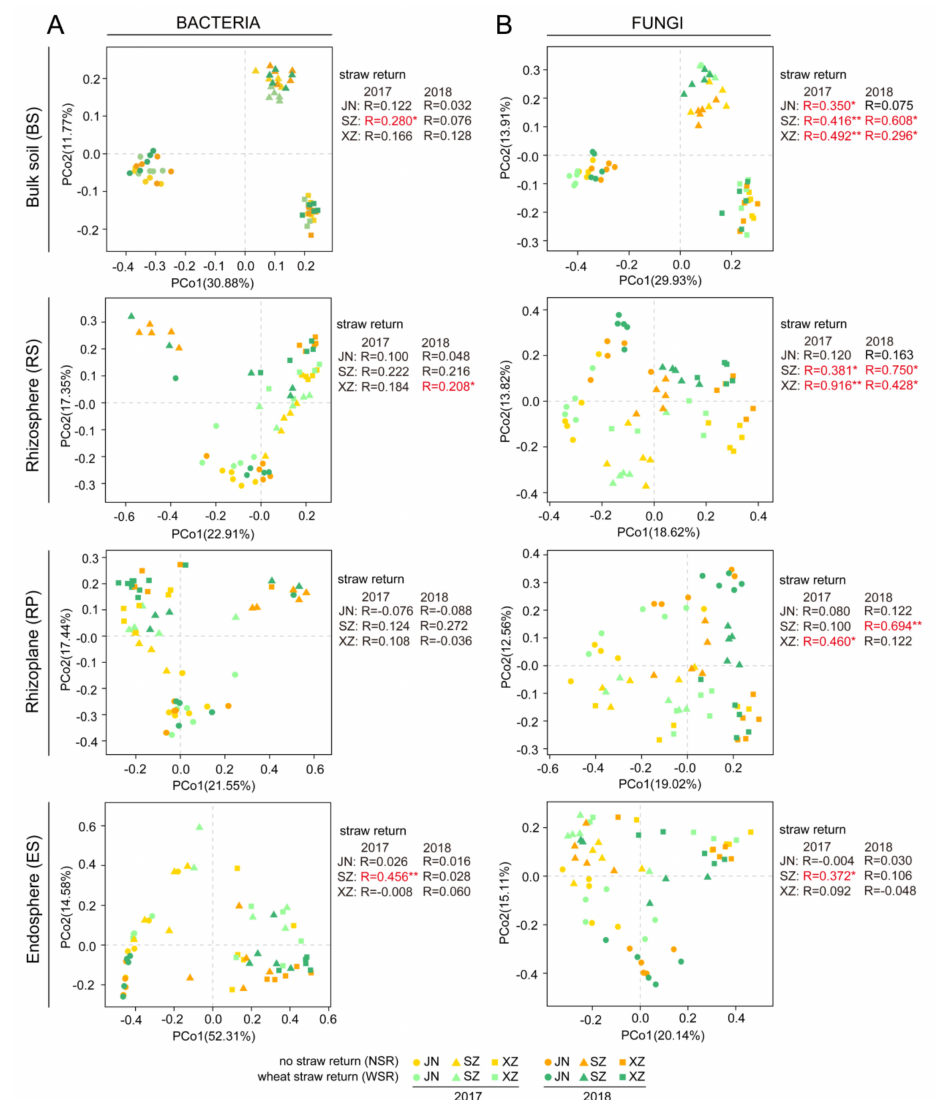
Figure 3. PCoAs showing the influence of WSR on bacterial ( A ) and fungal ( B ) community composi- tion in bulk soil (BS), rhizosphere (RS), rhizoplane (RP), and endosphere (ES) based on Bray–Curtis dissimilarities. ANOSIM was applied to test for differences in community composition due to WSR across different compartments, sites, and years; R values are indicated with “*” for p < 0.05, “**” for p < 0.01, and marked the font in